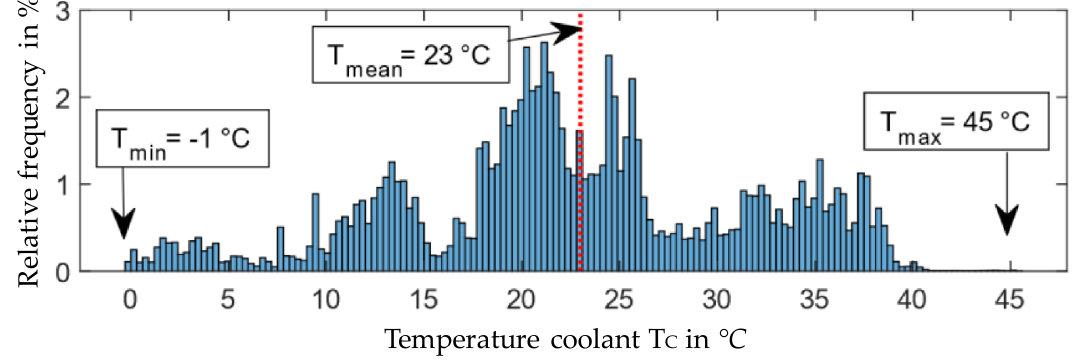
Figure 6. Machine winding overhang temperature for the NEmo.